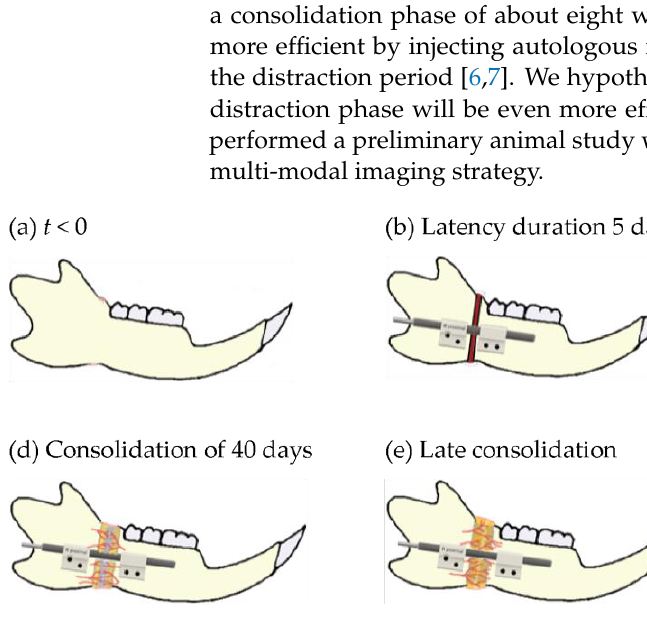
Figure 1. The phases of distraction osteogenesis. ( a ) Starting condition. ( b ) Latency phase of five days, in which the osteotomy-induced hematoma is formed and subsequently converted into granulation tissue. ( c ) Distraction phase with a regular speed of eleven days or with an elevated speed of four days, in which the two parts of the jawbone drift away through tension, and non-mineralized callus tissues are formed at a distraction gap. ( d ) During the consolidation phase of 40 days, osteogenesis extends to the middle of the gap. ( e ) During the late consolidation phase, the gap between the bone segments matures into a newly formed bone. ( f ) The remodeling phase begins after the completion of distraction osteogenesis. Here, the distractor is disconnected and lamellar bone forms.